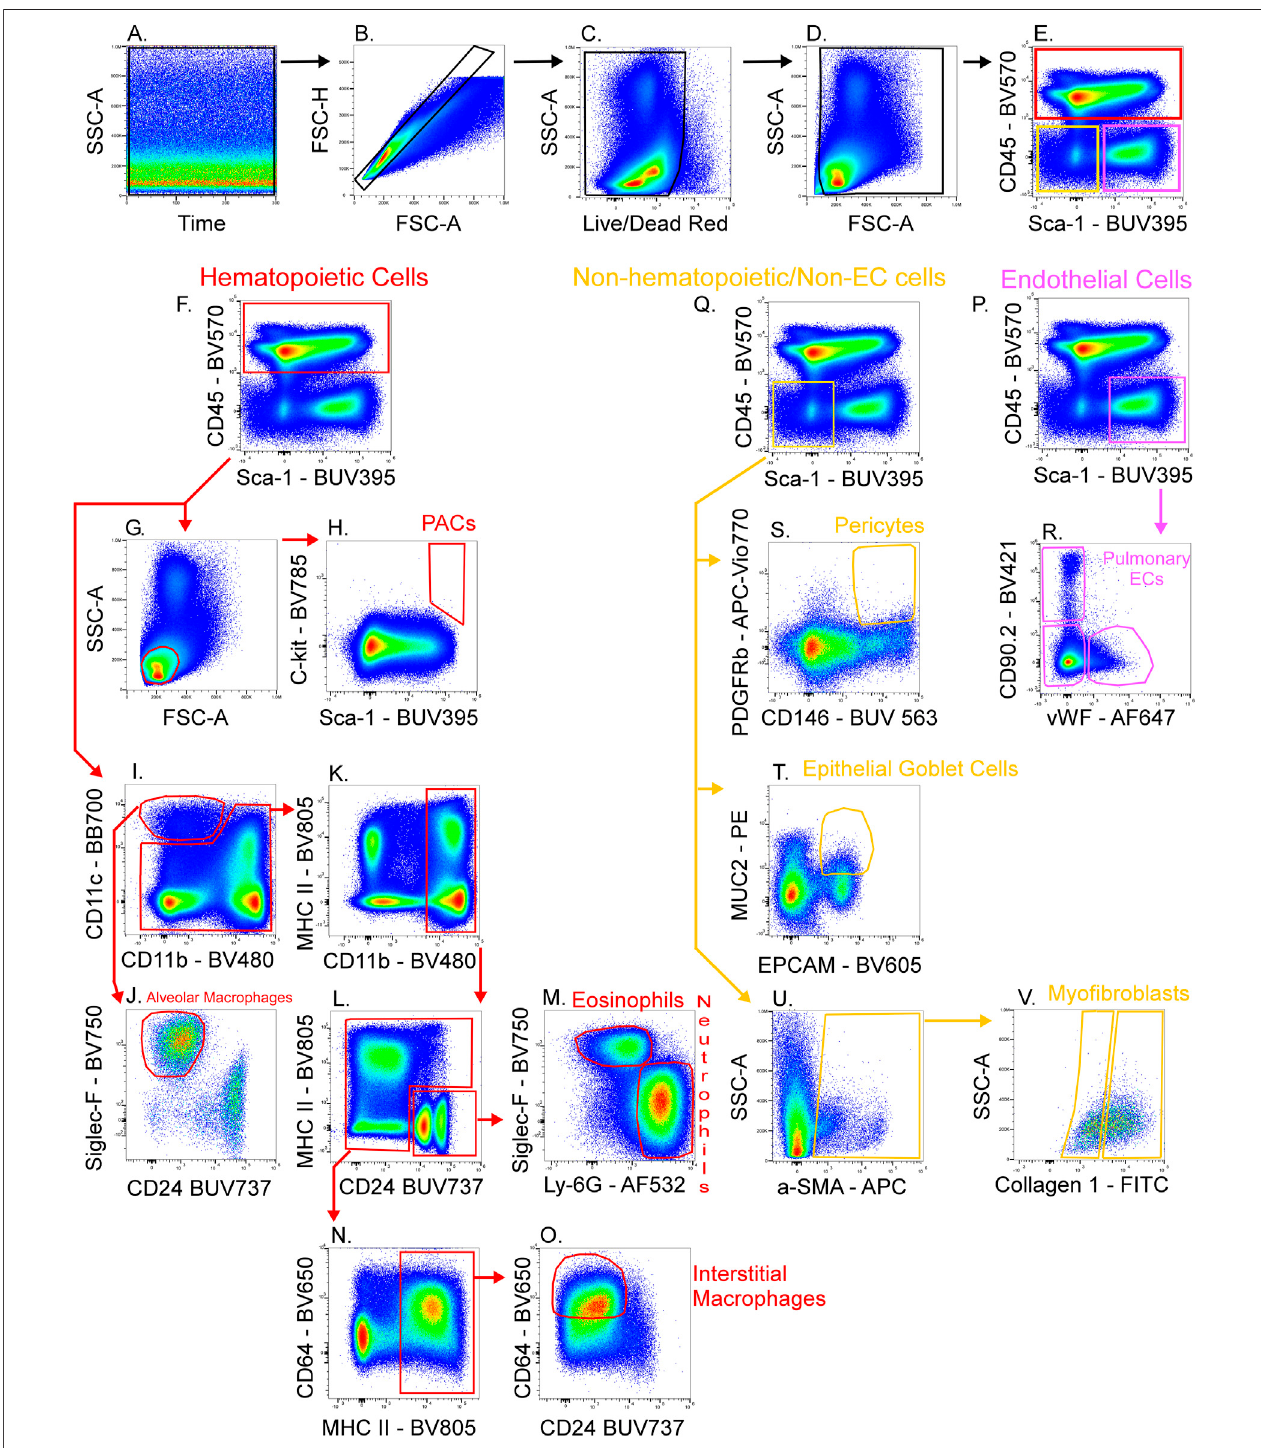
FIGURE5| Gating strategyforlung cellphenotyping. ThefullystainedsamplewasunmixedwithAFincluded intheID7000software, thenFCS fi les wereexported and opened in FlowJo. Sequential gating was used to identify cell populations. Data clean-up included time gating (A) , doublet exclusion (B) , viability gating (C) , and debris removal (D) . CD45 and Sca-1 were used to discriminate 3 populations (E) : hematopoietic cells (CD45 + ; red gate), endothelial cells (ECs) (CD45 − /Sca-1 + ; pink gate), and non-hematopoietic/non-EC cells (CD45 − /Sca-1 − ; yellow gate). A scatter plot (G) and expression of C-kit and Sca-1 de fi ned proangiogenic cells (PACs) (H) . CD11c + /CD11b − cells were gated (I) then expression of Siglec-F and absence of CD24 was used to gate alveolar macrophages (J) . CD11b + cells (K) were gated fromtheremainingcellsinplotI.CD24wasexpressed ongranulocytes (L) thenSiglec-F + eosinophilsandLy-6G + neutrophilsweregated (M)